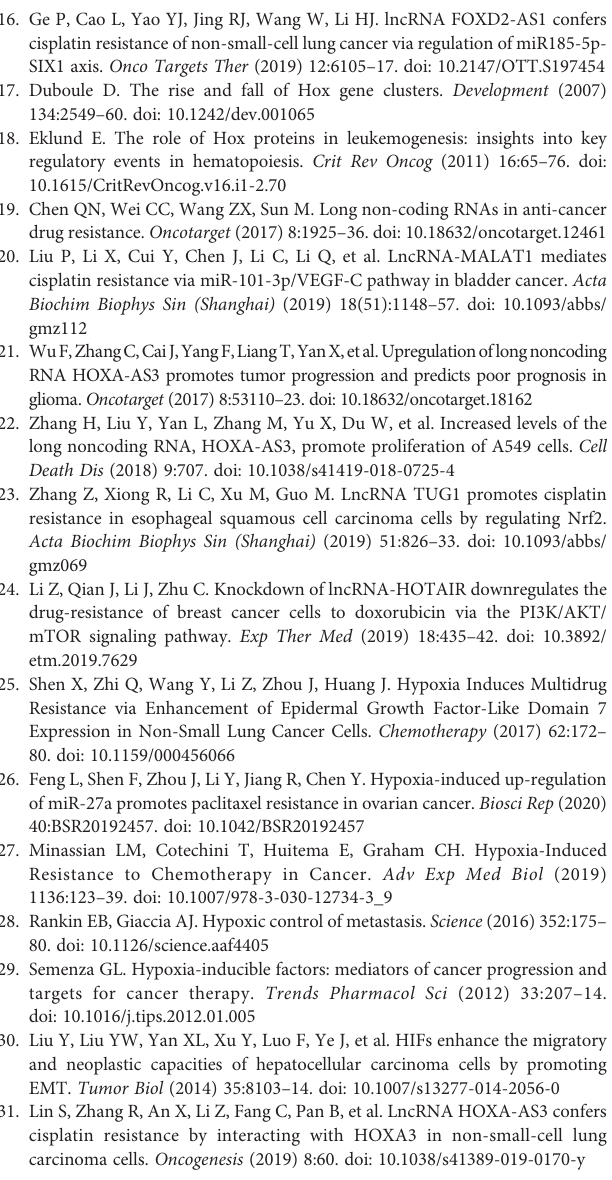
Supplementary Figure 1 | (A, B) . HOXA-AS3 expression in bladder cancer cells quanti fi ed by qRT-PCR after treatment with different concentrations of cisplatin (A) or for a different length of time (B) . Supplementary Figure 2 | (A – D) . CC-K assay analysis cell viability transfection with or without HOSA-AS3 plasmid and combined with cisplatin in BC cells, the expression of HOXA-AS3 was determined by qRT-PCR. *P<0.05 vs Control. Supplementary Figure 3 | A.QRT-PCR determined the expression of miRNA following treatment with or without cisplatin in BC